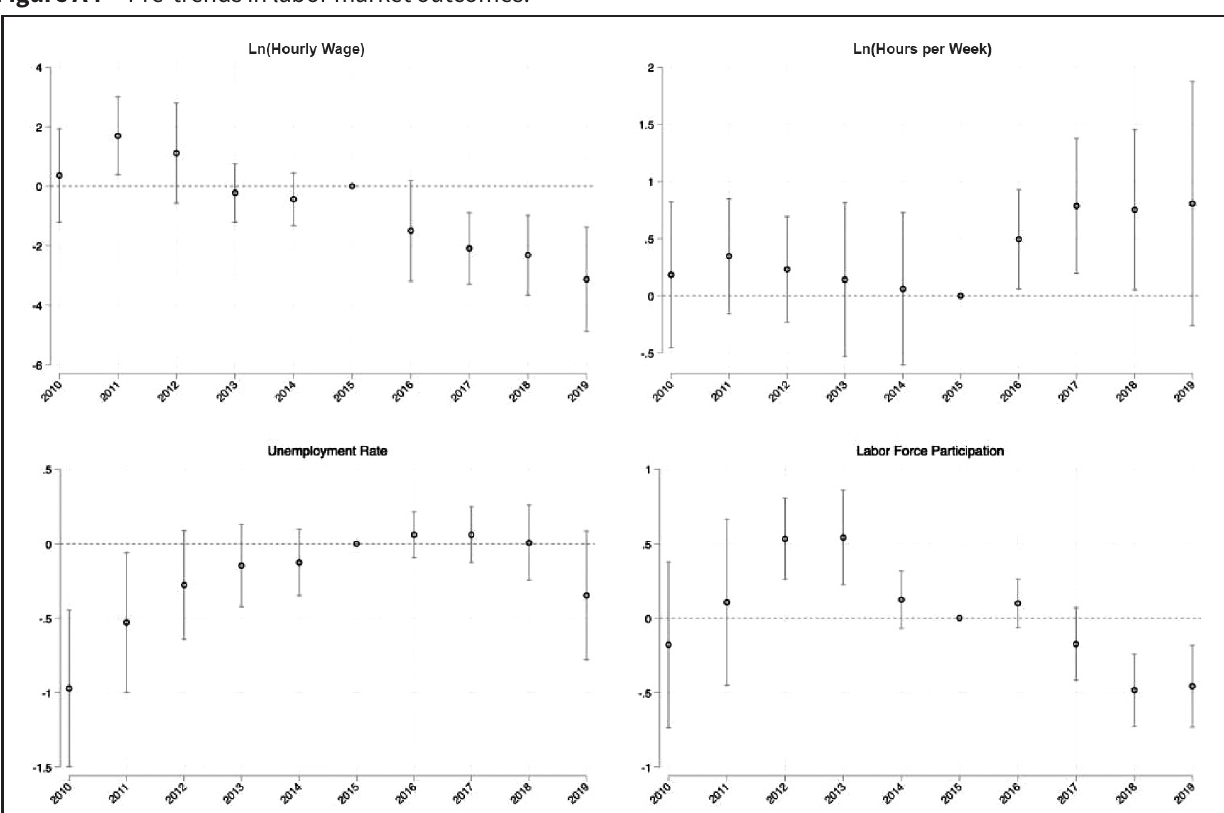
Figure A4 Pre-trends in labor market